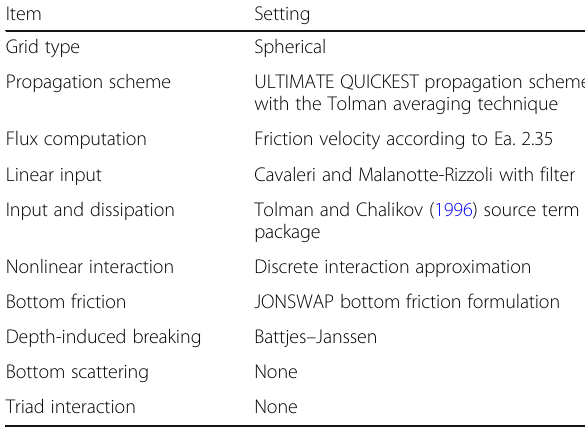
Table 2 Settings of the WRF simulations Item Table 3 Settings of the WW3